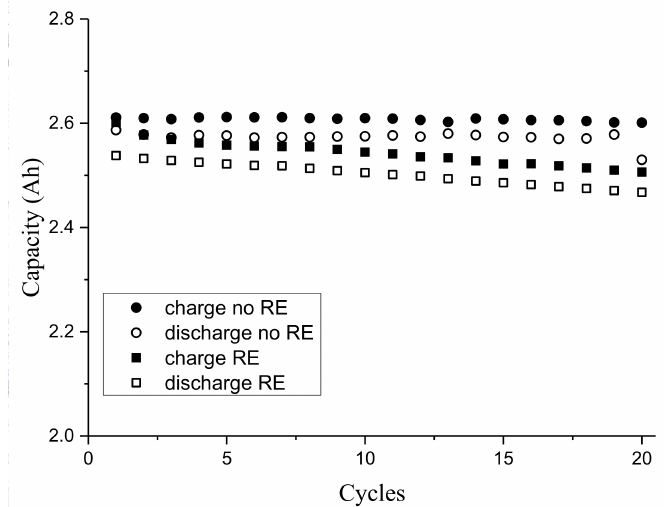
Figure 3. Cycling behavior at 25 ◦ C of a commercial cell before and after the insertion of a reference electrode (first ten cycles at 0.6/0.2 C, next five cycles at 0.8/0.2 C, and the final five cycles at 0.8/0.4 C for charge/discharge,